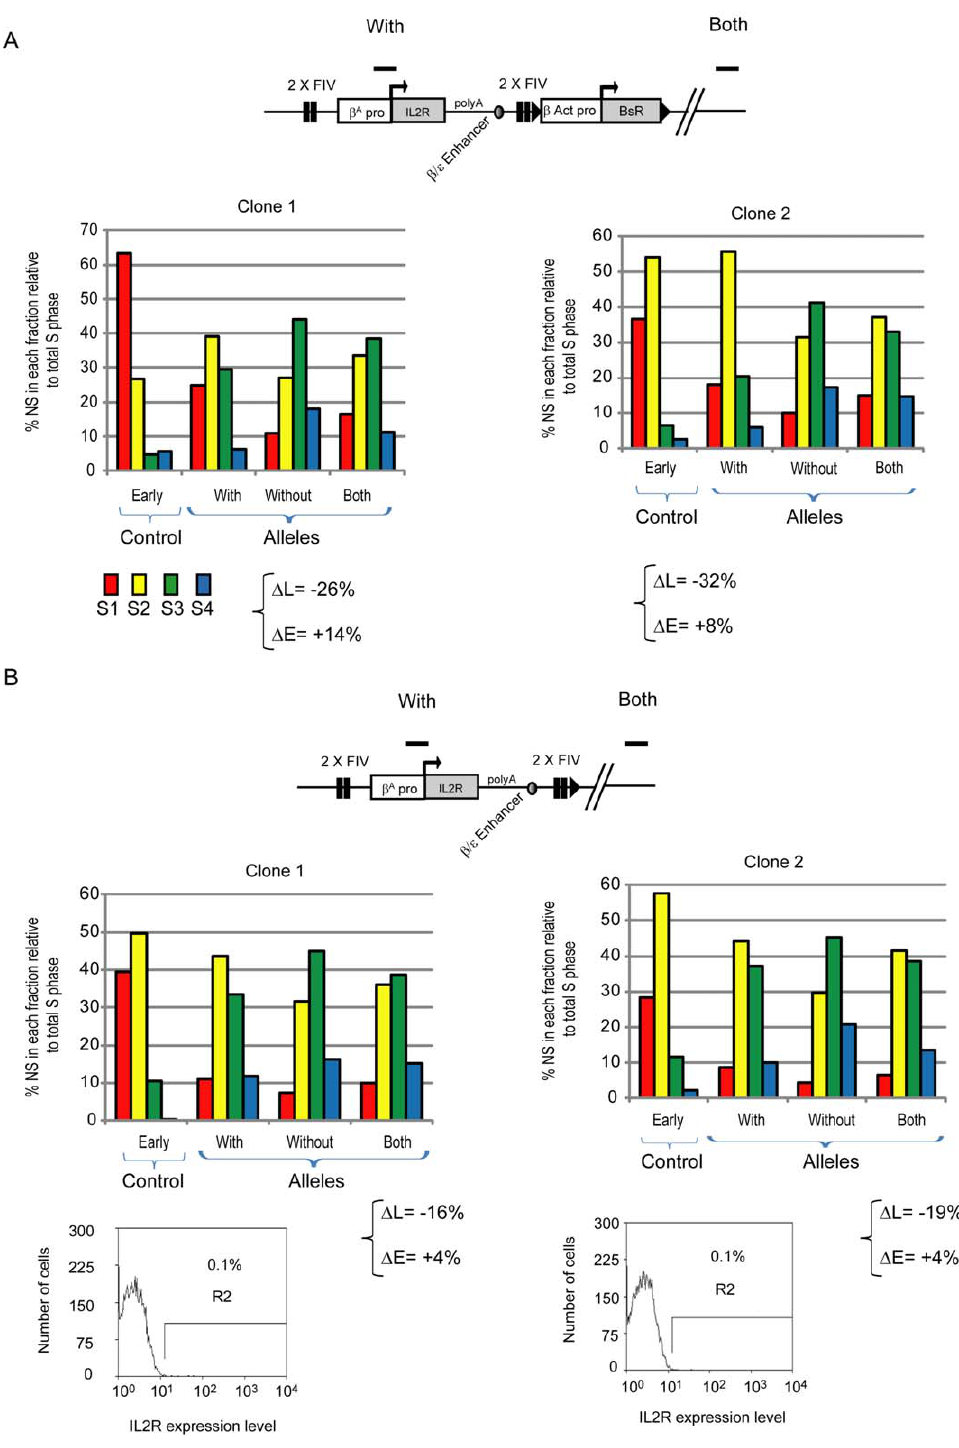
Figure 6. The USF binding site from the HS4 insulator is sufficient to direct early replication. (A and B) Replication timing profiles of chromosomal alleles following targeted transgene integration. The differences in late or early replication ( D L and D E) at the target site following transgene integration are shown. (A) Analyses of two clonal cell lines containing the IL-2R transgene flanked by two copies of the FIV USF binding site linked to the b -actin transgene. (B) Analyses of two clonal cell lines containing the same construct after recombinase-mediated excision of the b -actin transgene. Flow cytometric analysis of IL-2R expression is shown below for the two transgenic lines (clones 1 and 2).